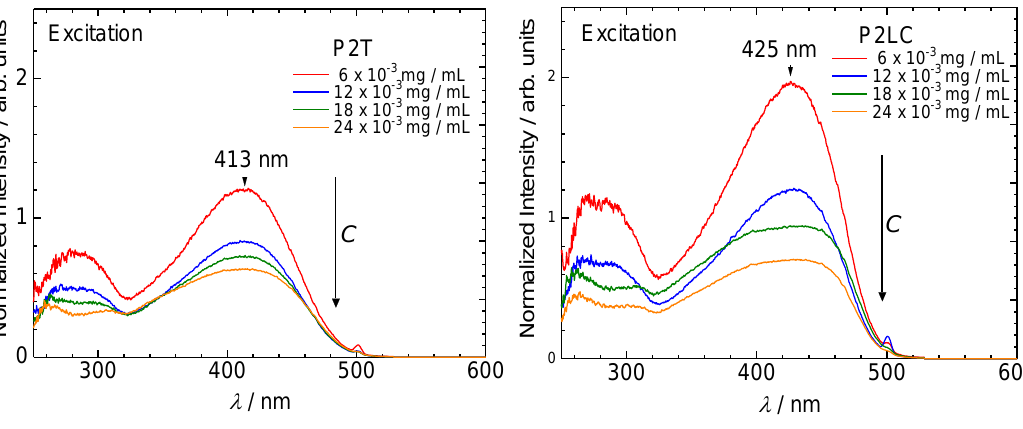
Figure 4. Excitation spectra for P2T (left) and P2LC (right) in chloroform